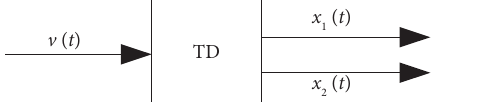
Figure 6: Sketch map of the TD of v .